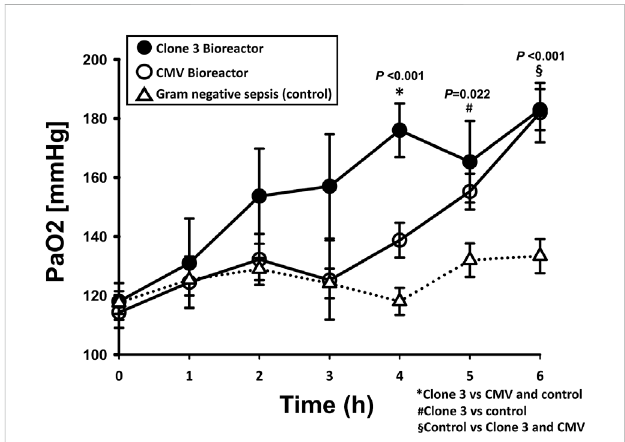
Effects of constitutively delivered sTNFR and TNF-- α --dependent delivery bioreactors on arterial partial pressure of oxygen (PaO 2 ) in the context of fi brin clot peritonitis (Gram--negative sepsis). Rats subjected to E.coli fi brinperitonitisfor24 h(time=0 h)werecannulatedfora further 6 h (total of 30 h of experimental sepsis) to bioreactors producing sTNFR either constitutively (CMV--driven: n = 4) or in a NF-- κ B--dependent manner (Clone 3: n = 3). Control animals (Gram-- negative sepsis without treatment: n = 8). PaO 2 was measured using the ISTAT system. p < 0.05 by Two--way